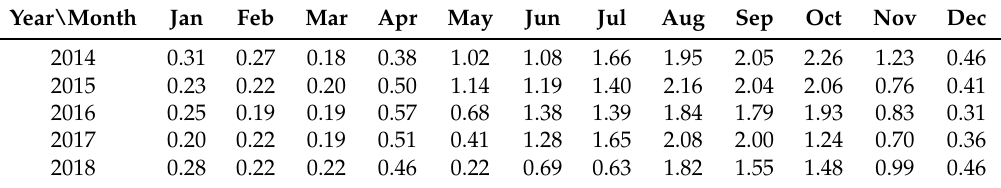
Table A6. Monthly minimums for surface salinity for the years